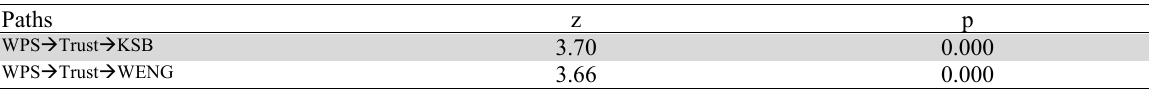
The results of the direct effects Paths